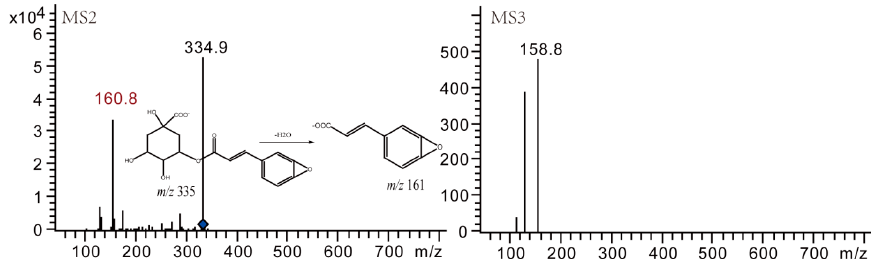
Figure 10. Negative MS n spectra and fragment ions of compound dehydrated products.